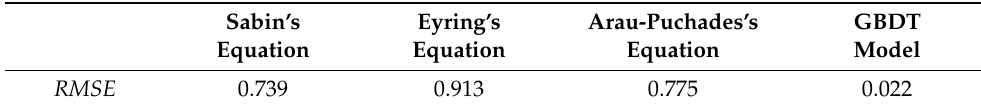
Table 11. The RMSE of reverberation time for 800 spaces. Figure 21. Scatter plot of reverberation time.